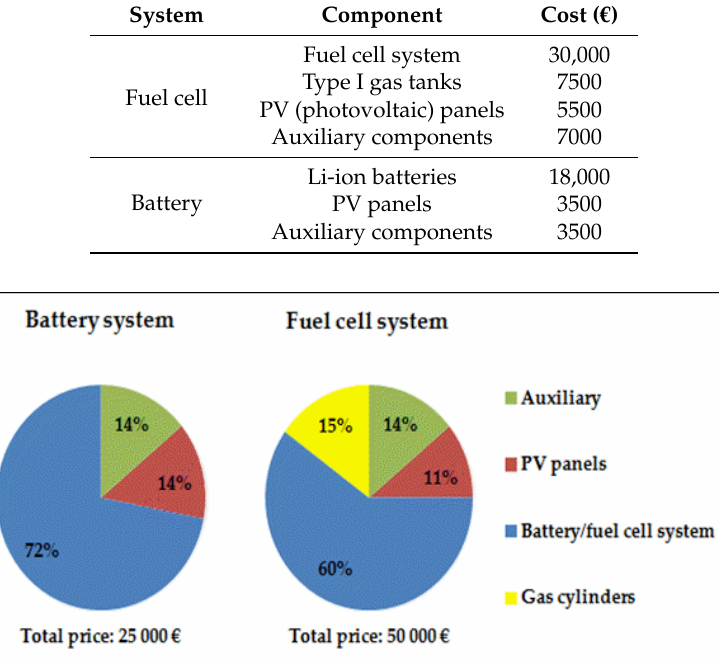
Figure 7. Total costs and cost distributions for the two alternatives of the stationary systems.